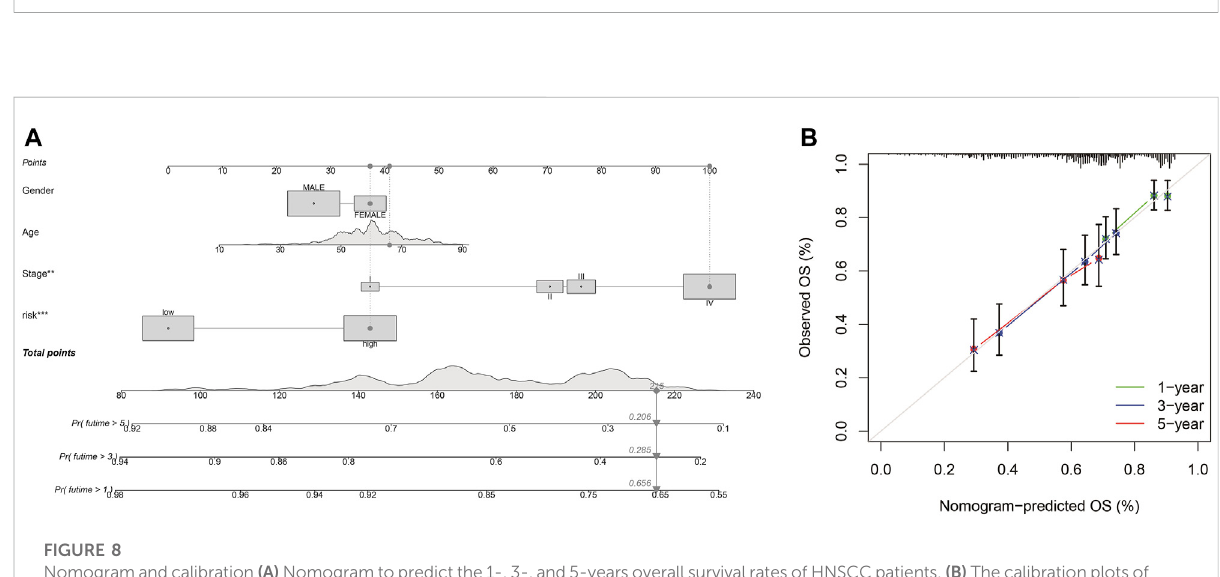
FIGURE 8 Nomogramandcalibration (A) Nomogramtopredictthe1-,3-,and5-yearsoverall survivalratesofHNSCC patients. (B) Thecalibrationplotsof the